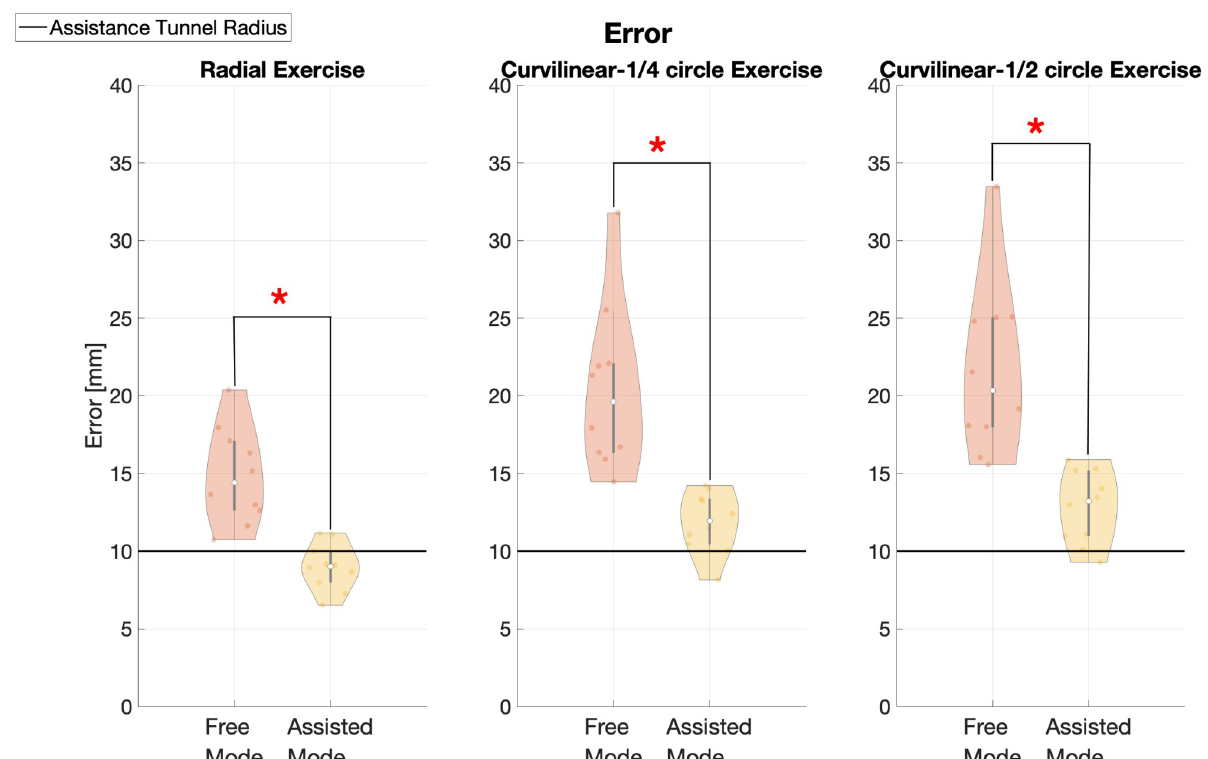
Fig 8. Summary of kinematics errors in the three modes. left panel: Radial free and Radial assisted; middle panel: Curvilinear free ¼ circle and Curvilinear assisted ¼ circle and right panel: Curvilinear free ½ circle and Curvilinear assisted ½ circle. The mean kinematic error after repetition averaging and across directions is shown for each subject. We displayed the radius of the assistance tunnel in